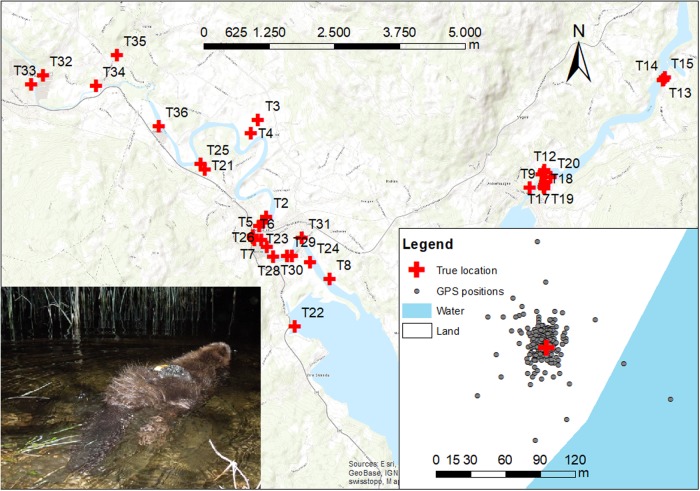
Study area in South-Eastern Norway, showing the 36 test sites (red crosses) where we tested the performance of GPS receivers (large map).The small map shows GPS locations (grey dots) for one exemplary test site, and the picture shows a Eurasian beaver (Castor fiber), equipped with a GPS unit on its lower back.